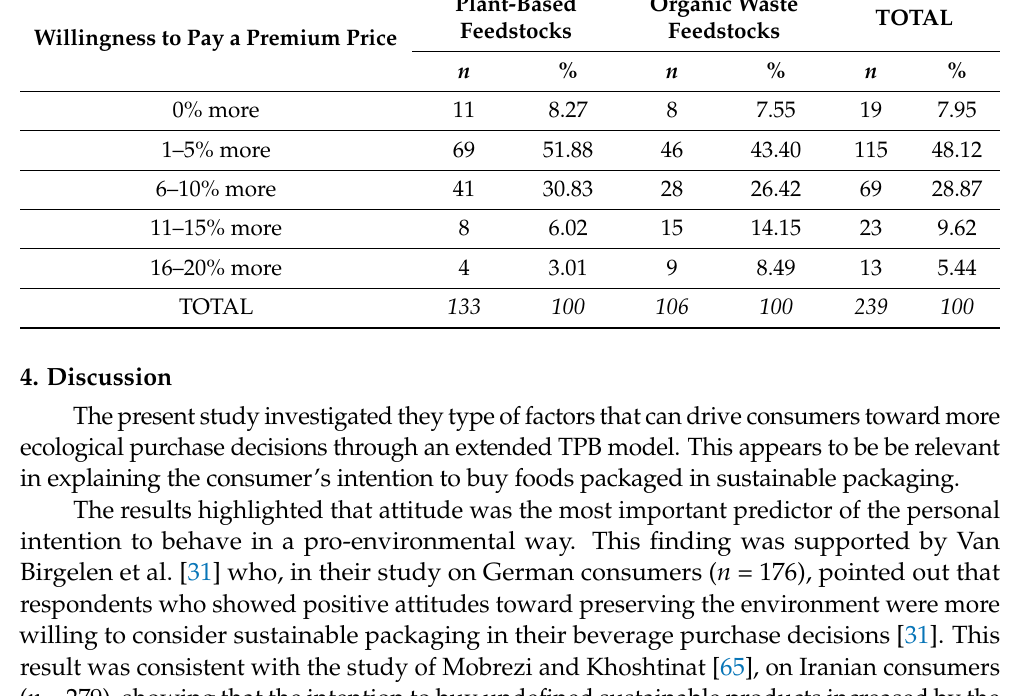
Table 3. Consumers’ willingness to pay a premium price for milk packaged in biodegradable packaging. Plant-Based Willingness to Pay a Premium Price